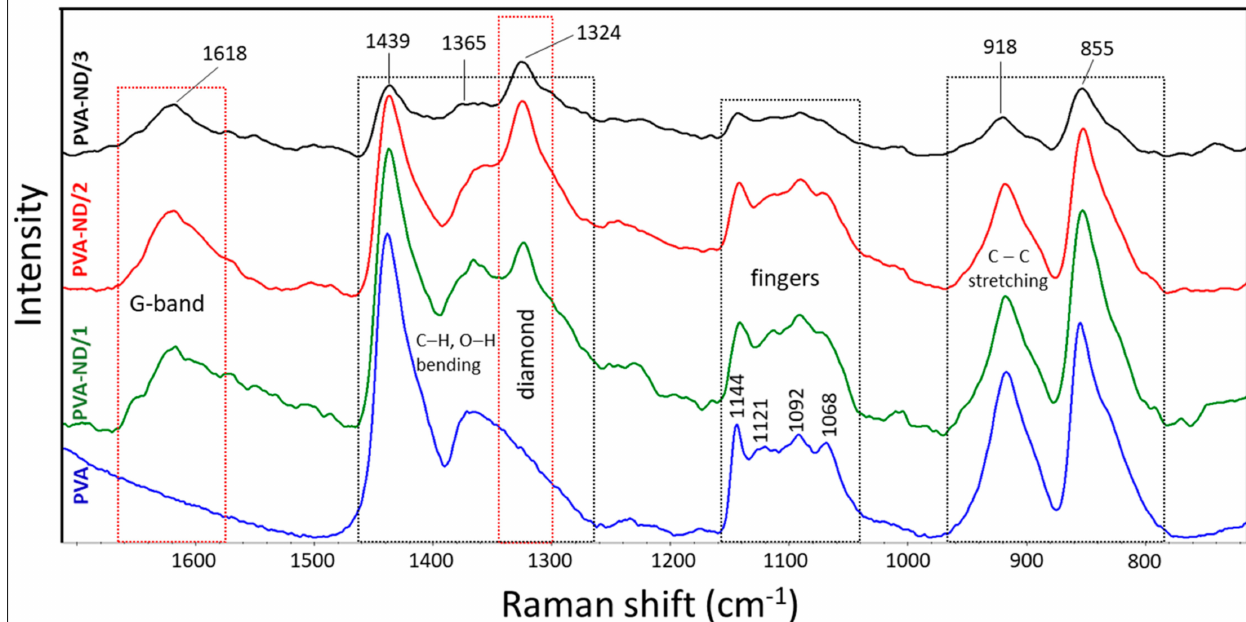
Figure 2. Raman spectra of the PVA and the PVA-NDs nanocomposite